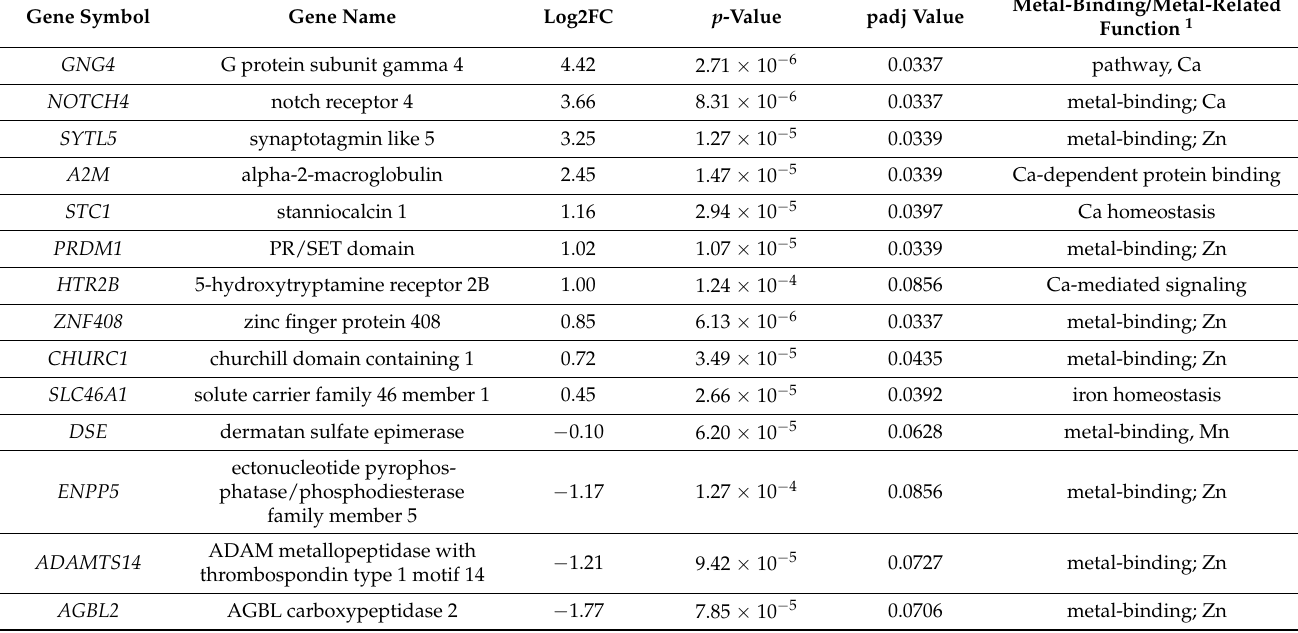
Table 2. Differentially expressed genes (DEGs) with metal-ion binding abilities or other metal-related function between the mild cognitive impairment (MCI) and control olfactory mucosa (OM) cells identified by total RNA sequencing. FC, fold change. padj-value (adjusted p -value, false discovery rate) <